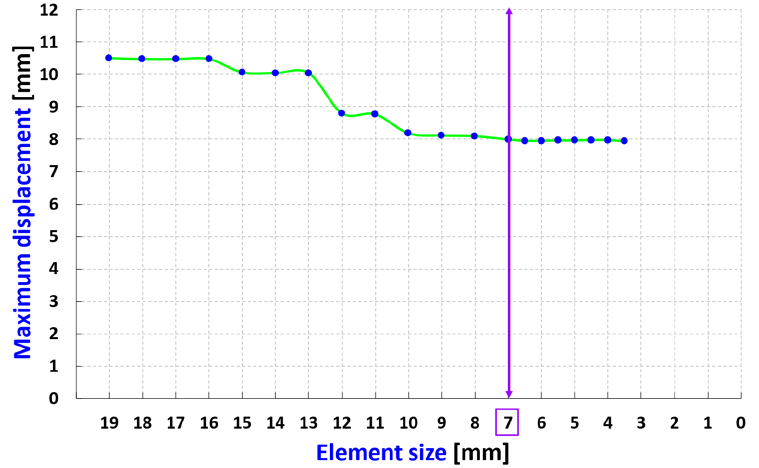
Figure 5. Mesh convergence study—maximum displacement as a function of element size.